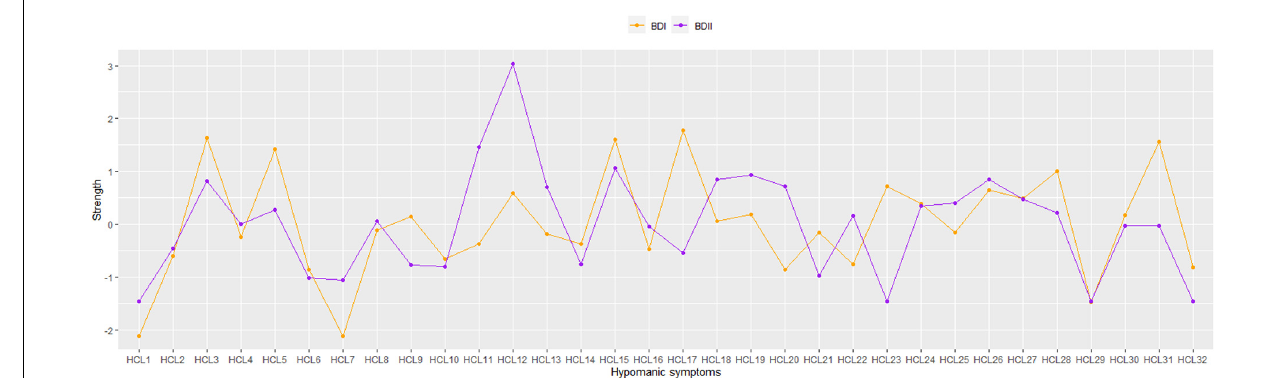
FIGURE 2 | Strength centrality for each node included in the network (z-scores).